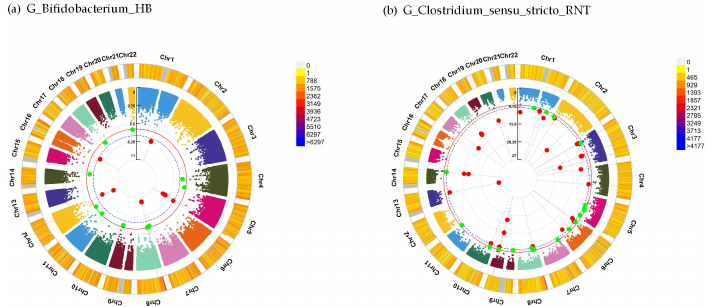
G_ Clostridium _sensu_stricto_RNT